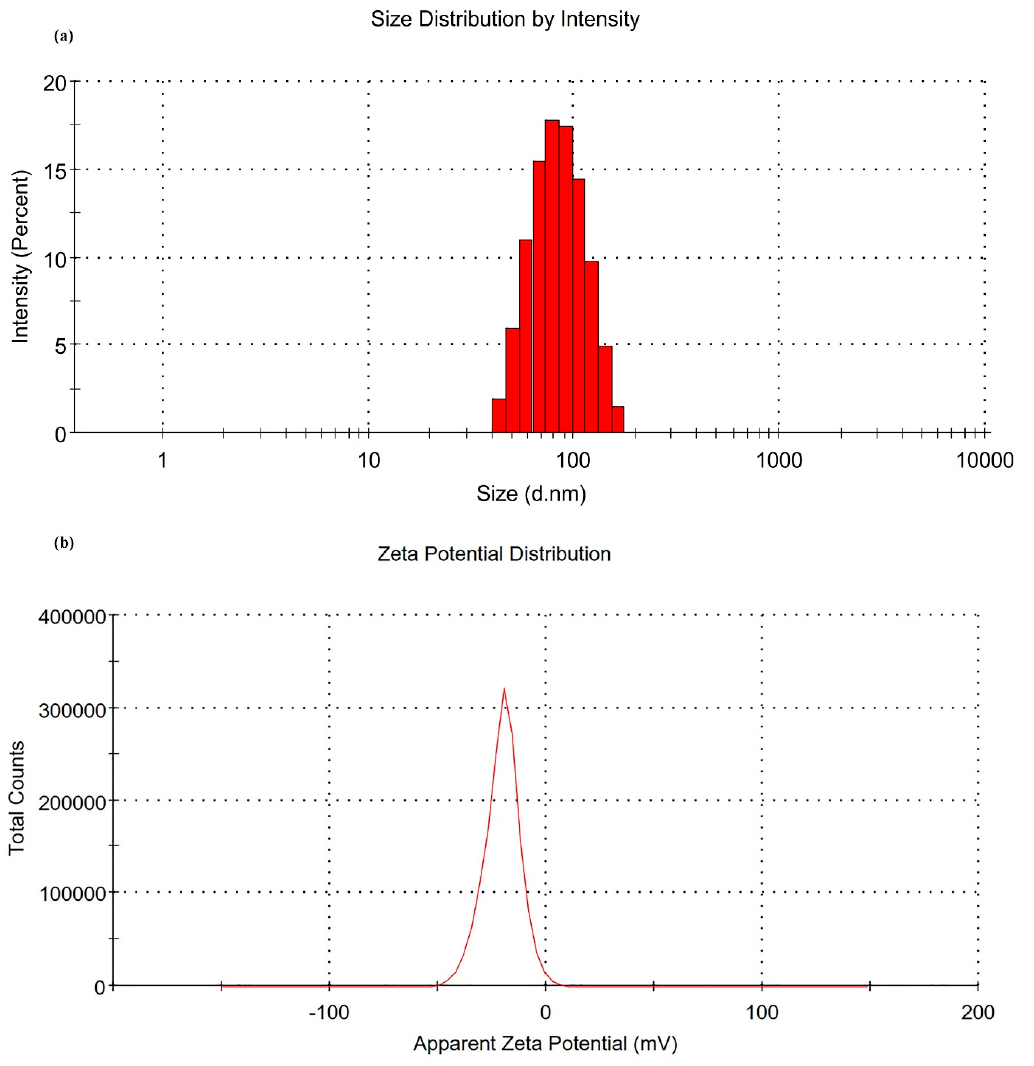
Figure 4. ( a ) Droplet size distribution of NE4. ( b ) Zeta potential distribution of NE4.